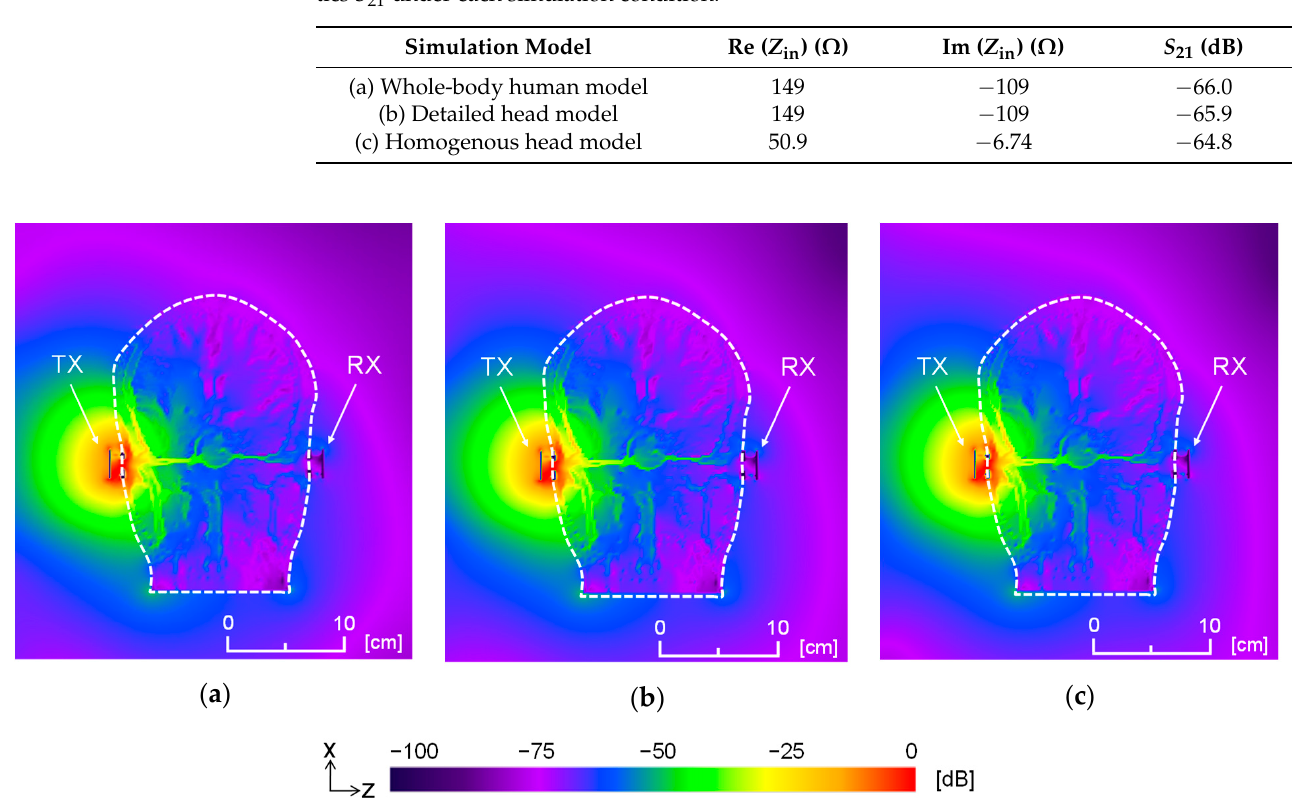
Table 2. Analysis results of the two-electrode transceiver: impedances and transmission characteris- tics S 21 under each simulation condition.